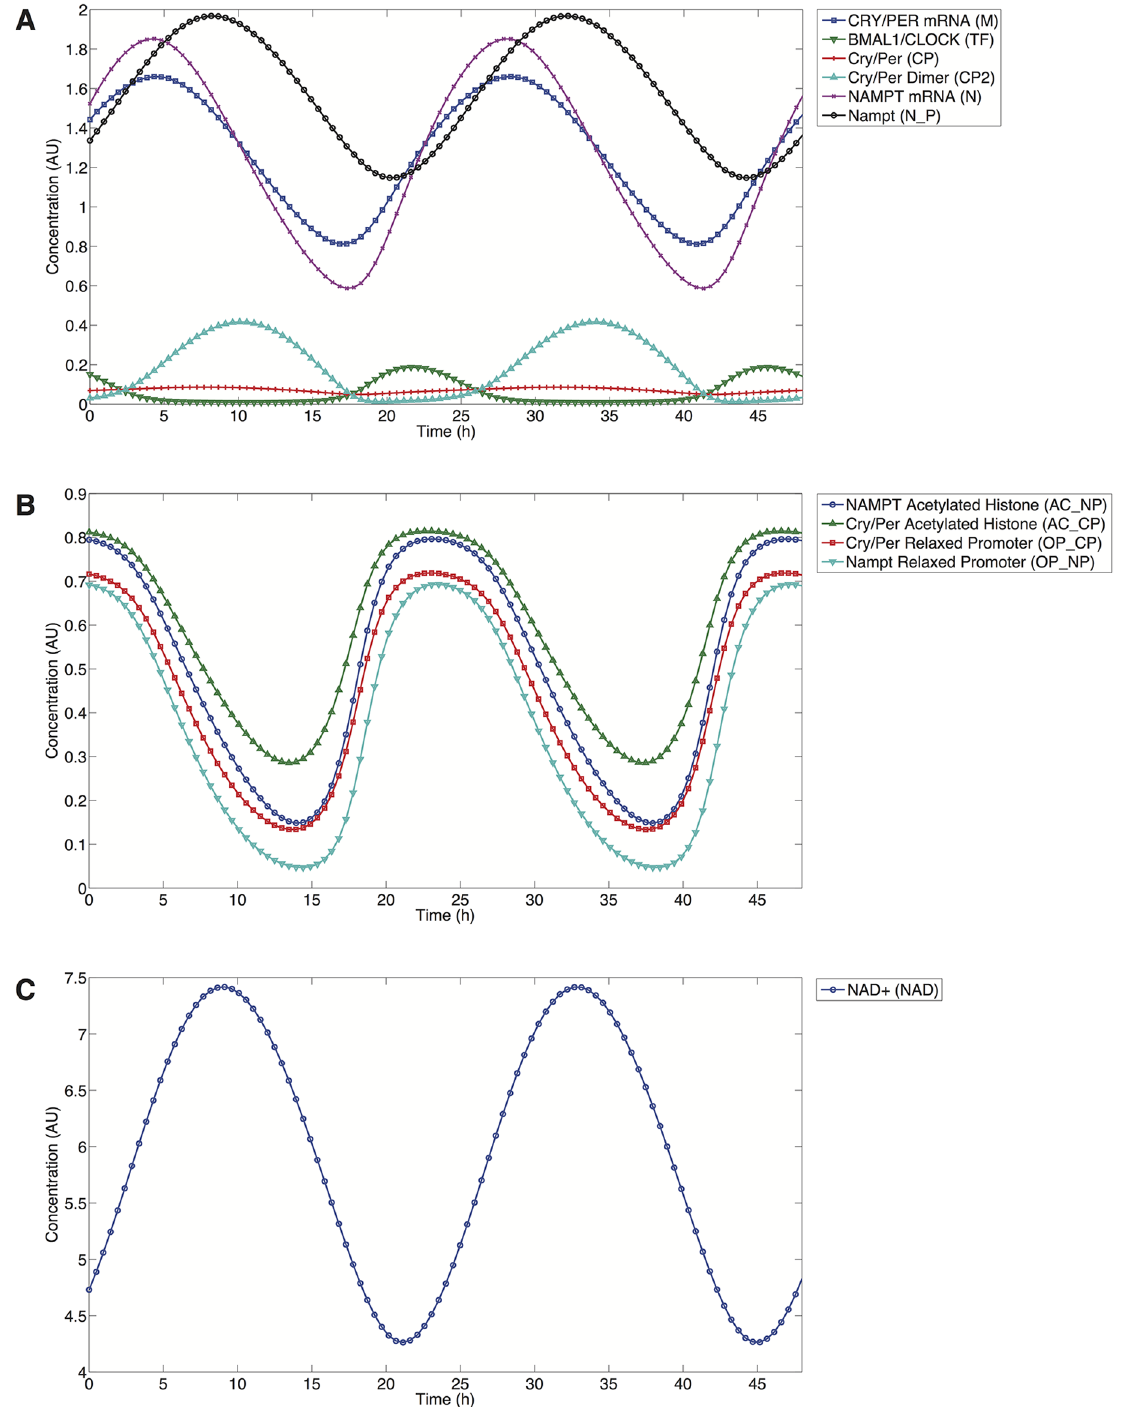
Fig 2. Current model time series. A) Main components: Blue/Square: CRY/PER mRNA, Green/Down Triangle: BMAL1/CLOCK, Red/Plus: CRY/PER, Cyan/Up Triangle: CRY/PER Dimer, Purple/X-Mark: NAMPT mRNA, Black/Circle: NAMPT protein. B) Histones and relaxed chromatin. Blue/Circle: NAMPT single histone acetylation levels, Green/Up Triangle: CRY/PER single histone acetylation levels, Red/Square: CRY/PER DNA accessibility value for relaxed promoter, Cyan/Down Triangle: NAMPT DNA accessibility value for relaxed promoter. C) NAD. Blue/Circle: NAD concentration. Parameters taken from Table 2 for the current